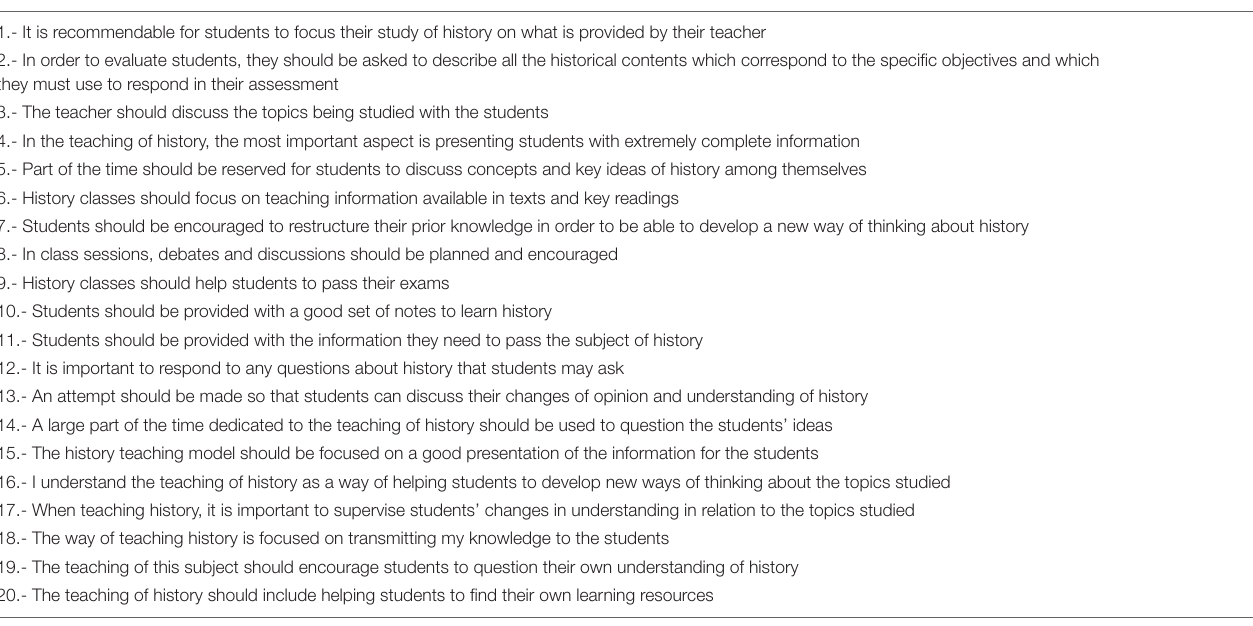
TABLE 1 | Approaches to teaching inventory